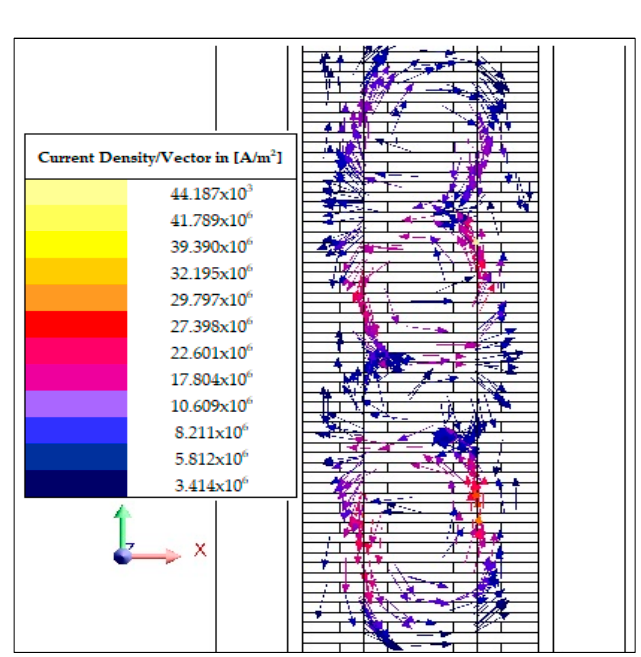
Figure 12. Spatial distribution of eddy currents in model 1.